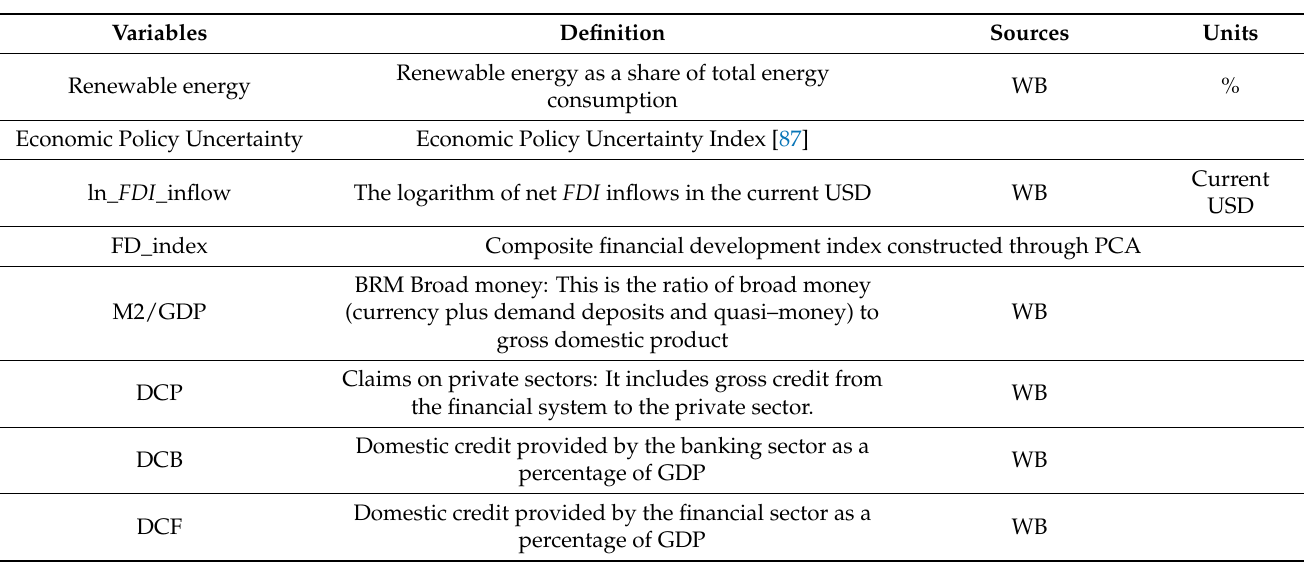
Table 2. Summary of data for empirical